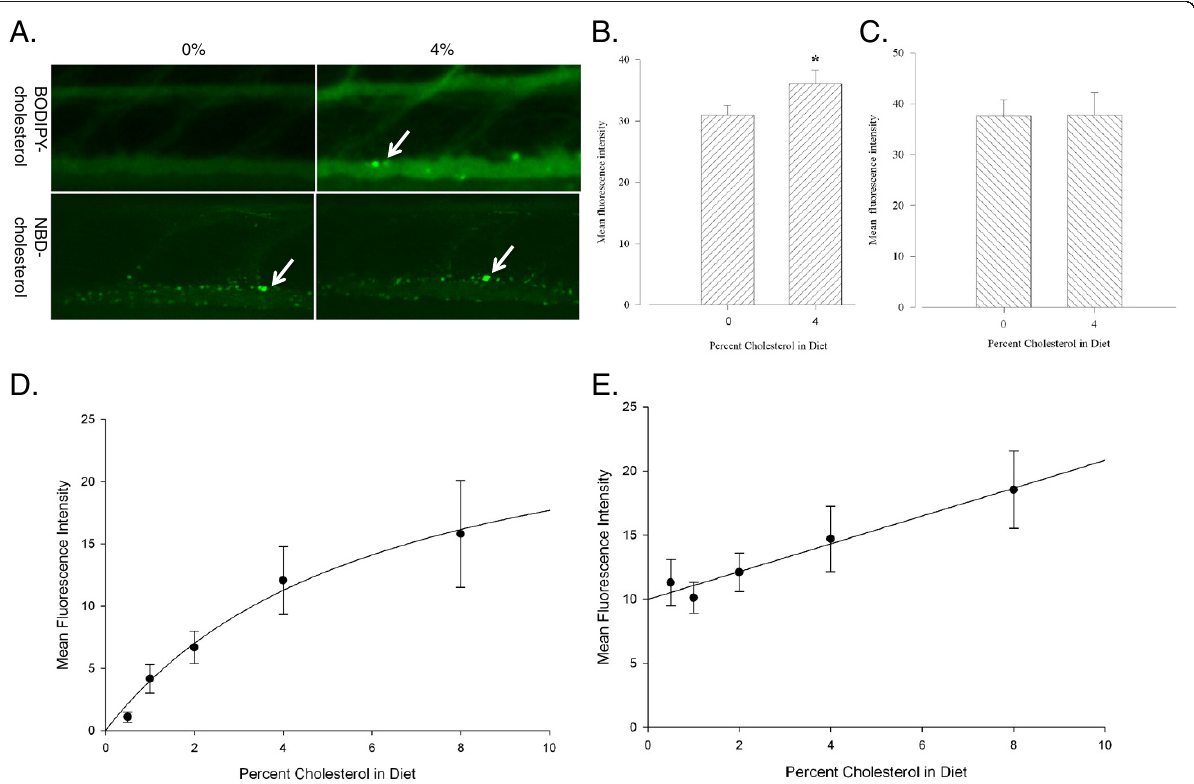
Figure 1 BODIPY-cholesterol (BOD-CH) vs. NBD-cholesterol (NBD-CH). A . Green is BOD-CH and NBD-CH fluorescence. Arrows point to fluorescent deposits in vasculature. Top panel: 0% HCD+10 μ g/g BOD-CH vs. 4% HCD+10 μ g/g BOD-CH. Bottom panel: 0% HCD+10 μ g/g